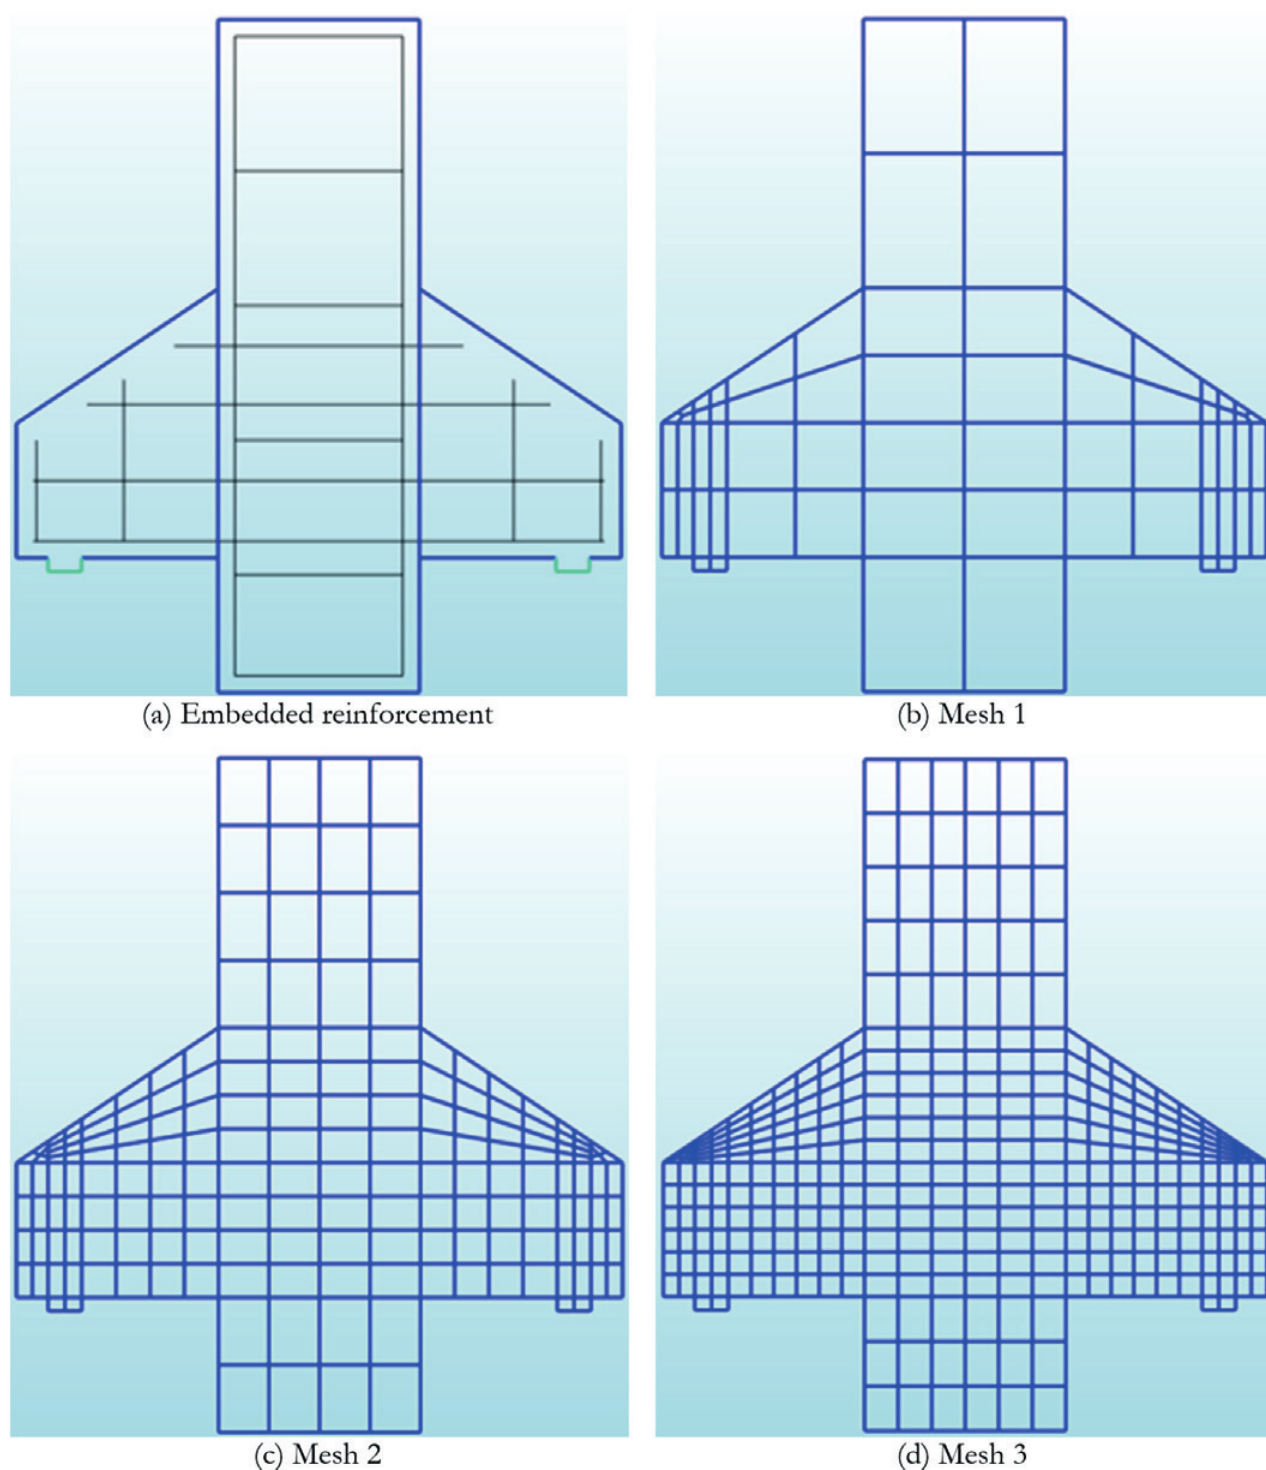
Figure 13 Reinforcements and meshes used in convergence